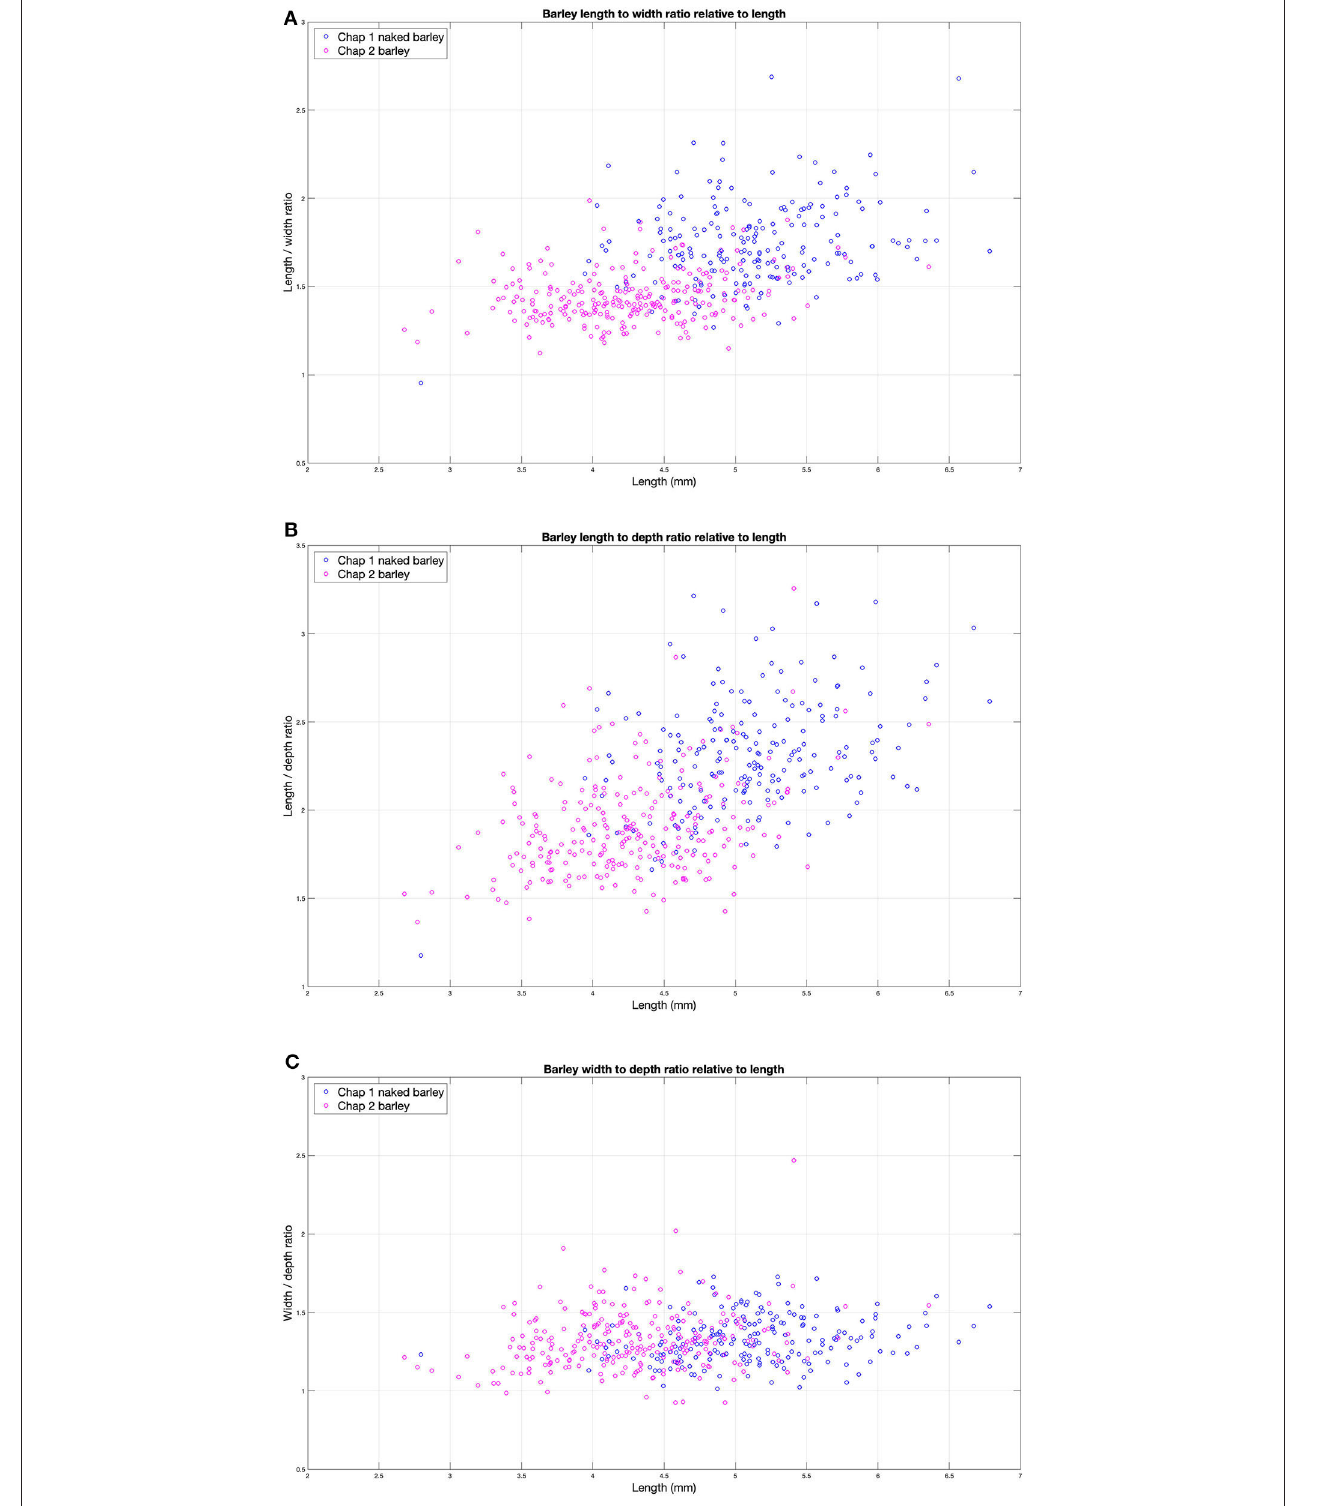
FIGURE 3 | The ratios of the naked barley grains from Chap I and Chap II: (A) length (L) to width (W), (B) length (L) to depth, and (C) width (W) to depth Q20 (D) all relative to the length for evaluation the characteristics in seed size change through time.